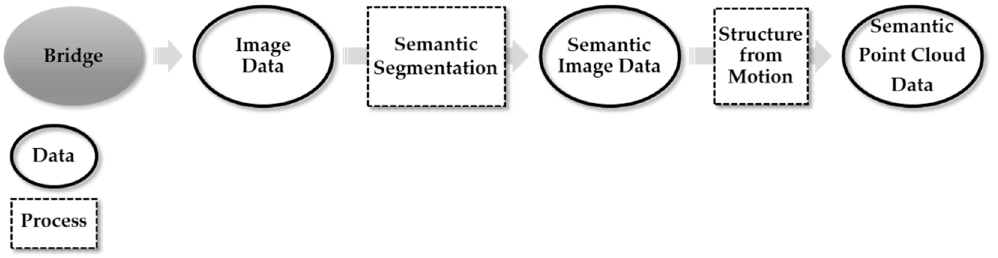
Figure 5. Overview of the proposed SSfM system.